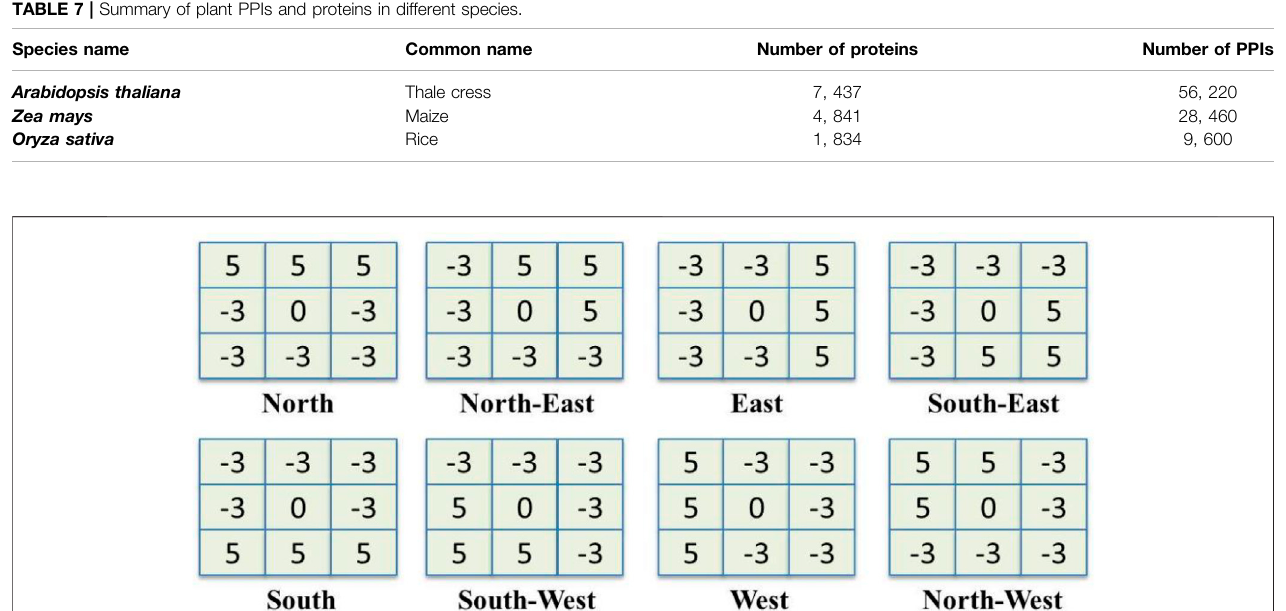
Frontiers in Genetics |